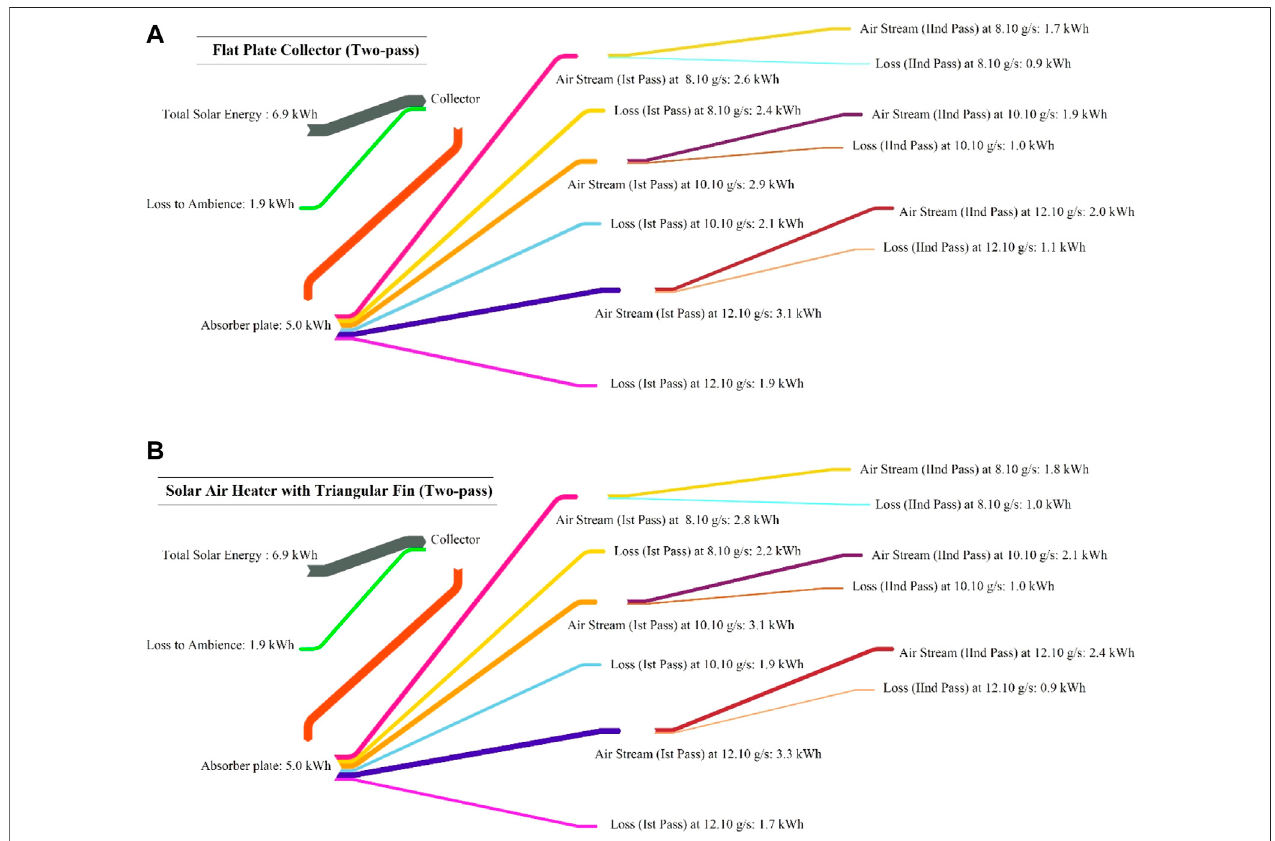
FIGURE 12 | Energy diagram for the solar air collectors. (A) Flat plate collector; (B) fl at plate collector with fi ns.